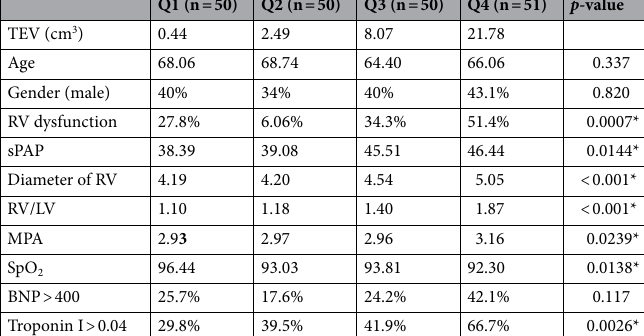
Table 3. Total emboli volume (TEV) quartiles. TEV total embolic volume, RV right ventricle, LV left ventricle, sPAP systolic pulmonary artery pressure, BNP B-type natriuretic peptide, MPA diameter of main pulmonary artery. * The threshold for statistical significance was p < 0.05.